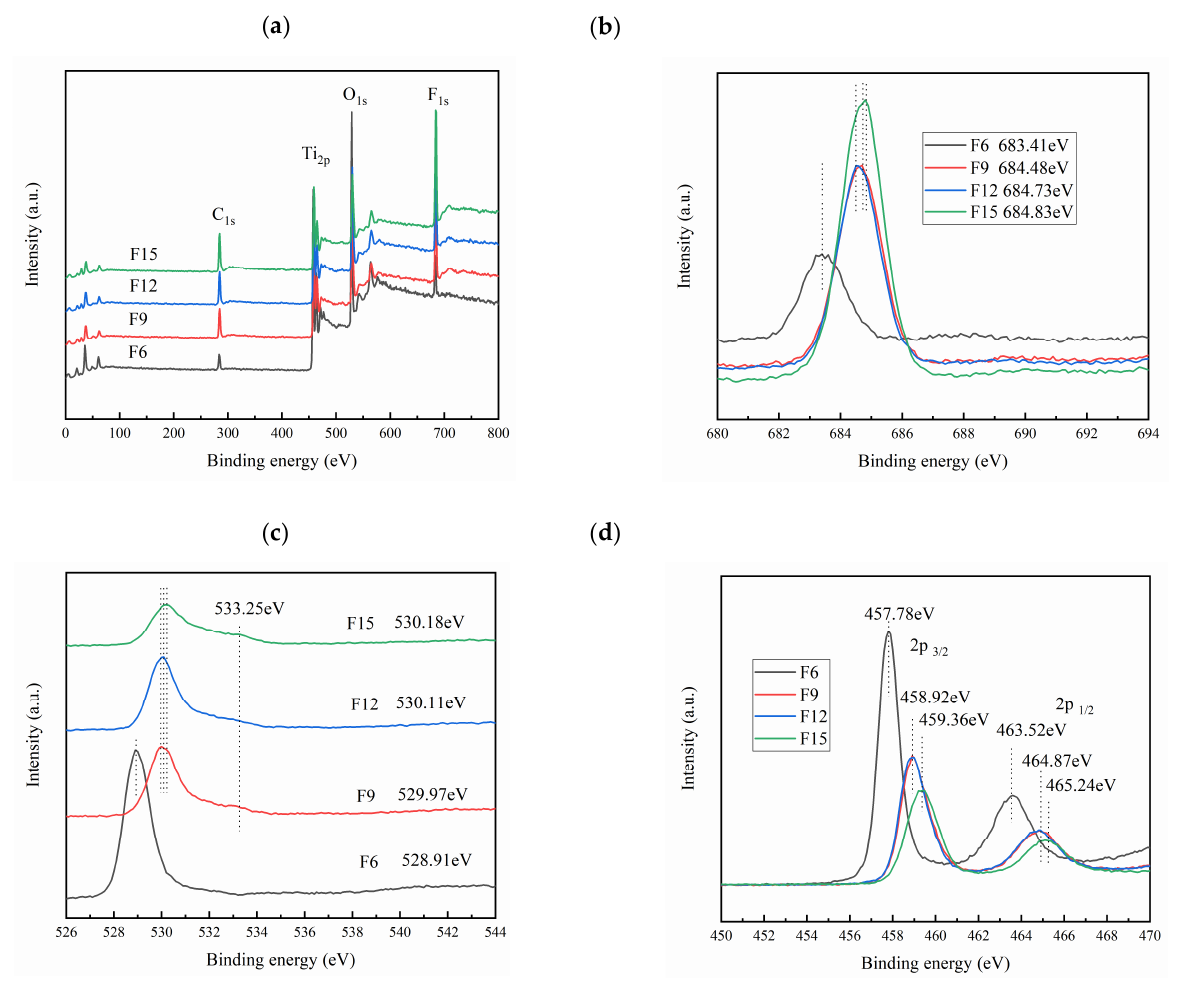
Figure 7. XPS survey spectra for ( a ) all samples, ( b ) F 1s, ( c ) O 1s, and ( d ) Ti 2p of the samples.